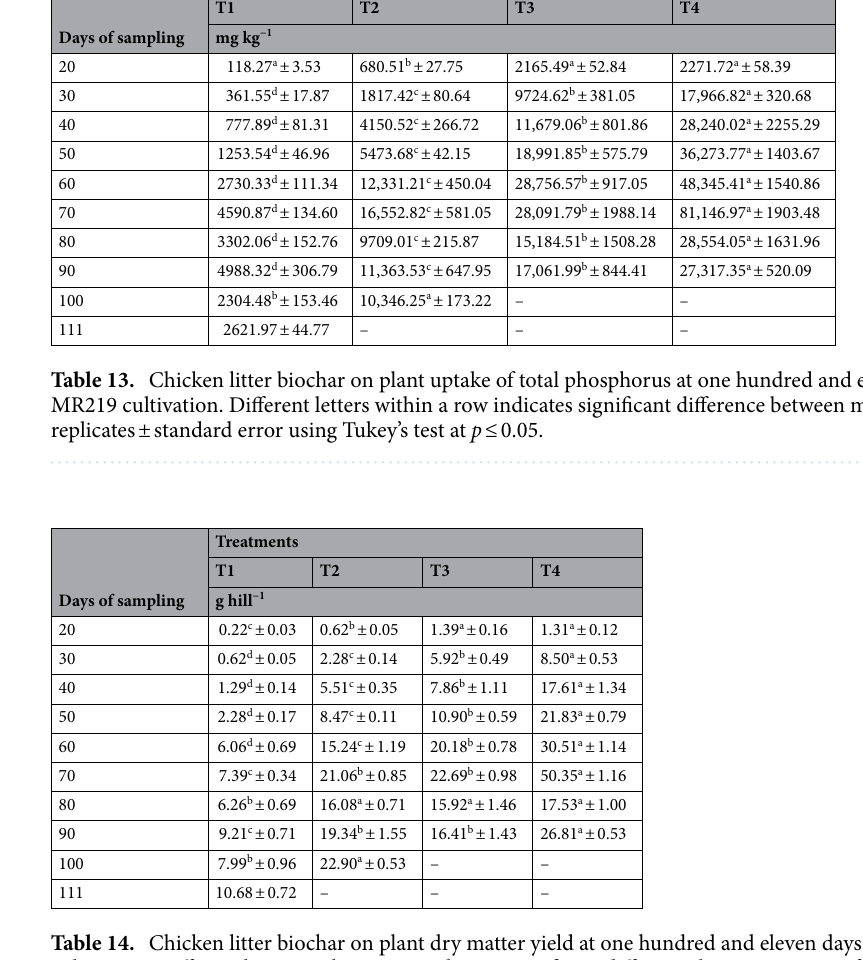
Table 14. Chicken litter biochar on plant dry matter yield at one hundred and eleven days of MR219 cultivation. Different letters within a row indicates significant difference between means of four replicates ± standard error using Tukey’s test at p ≤